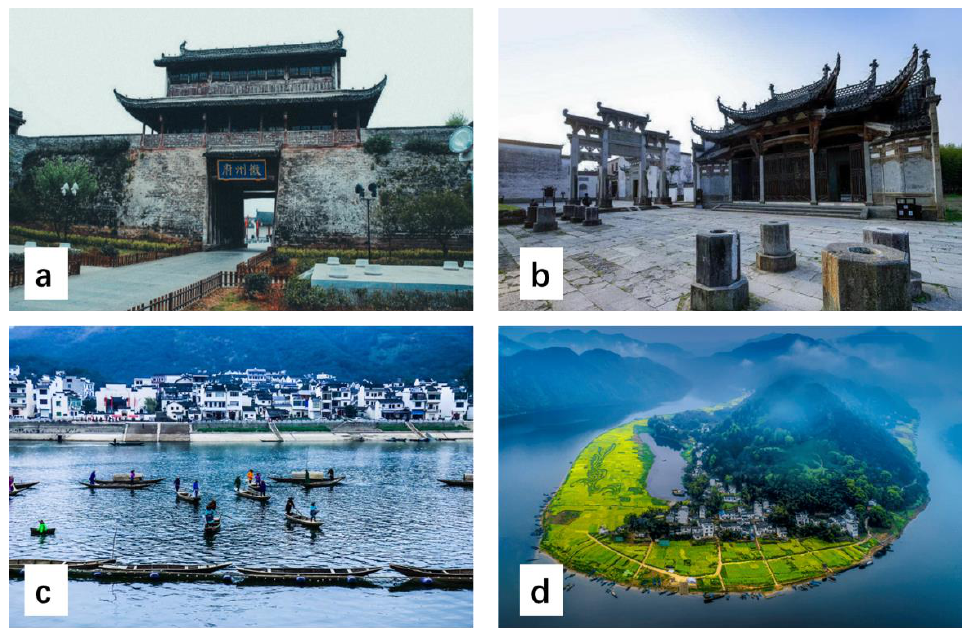
Figure 2. Some pictures used in the Q method. ( a ) Huizhou ancient city, ( b ) Huizhou ancestral hall, ( c ) traditional fishing culture, ( d ) natural scenery.